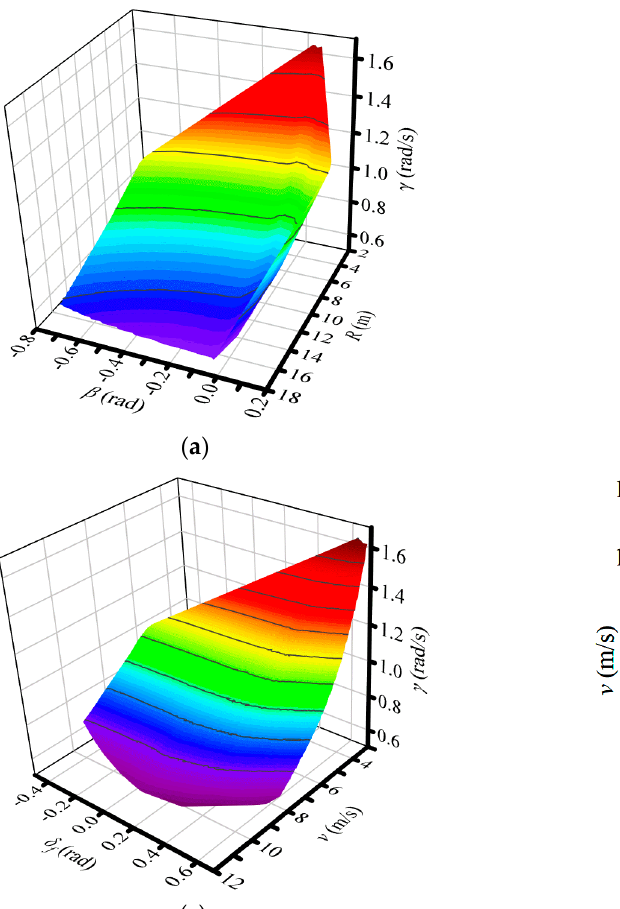
Table 2. The vehicle main status parameters in drift motions based on the steady-state analysis.